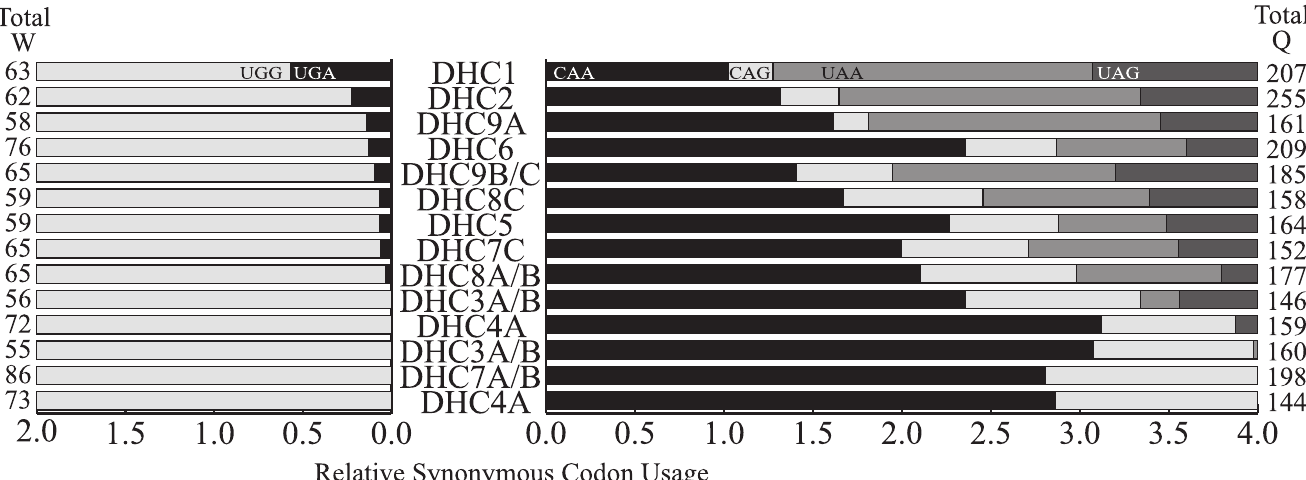
PLOS ONE | https://doi.org/10.1371/journal.pone.0212912 February 28,